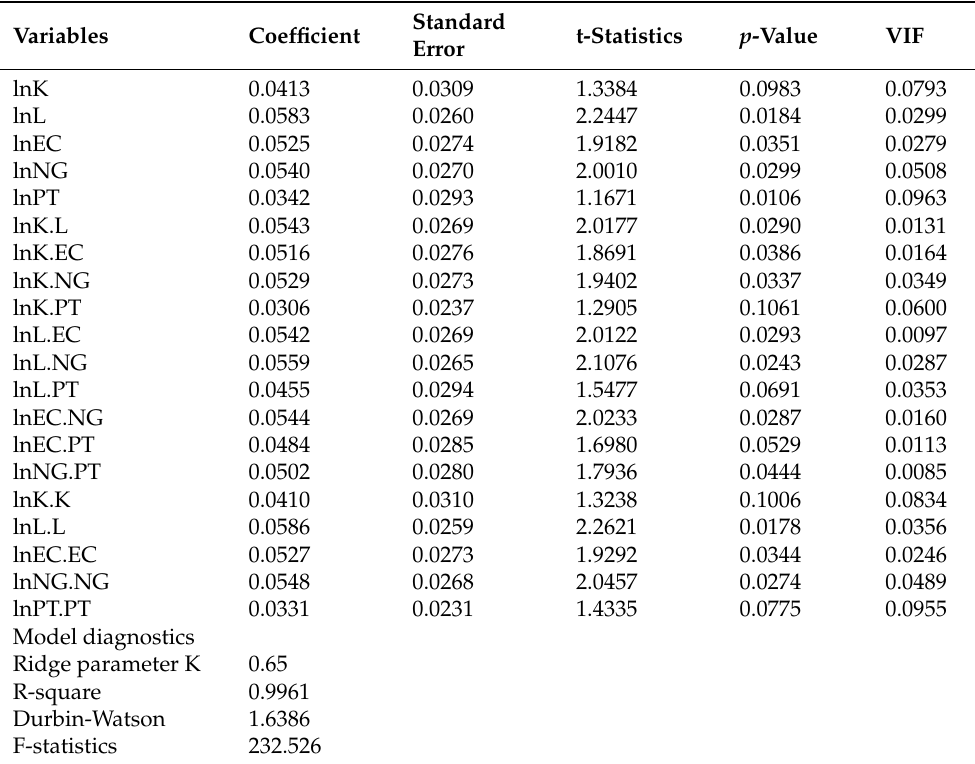
Table 2. Outcomes of ridge regression estimate when k =